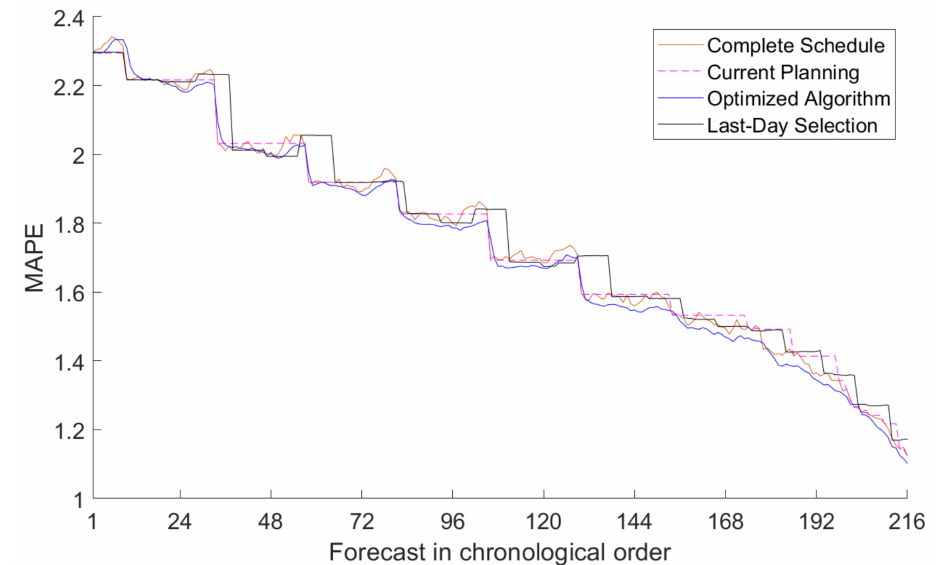
Figure 9. Accuracy of STLF in respect of order of execution.